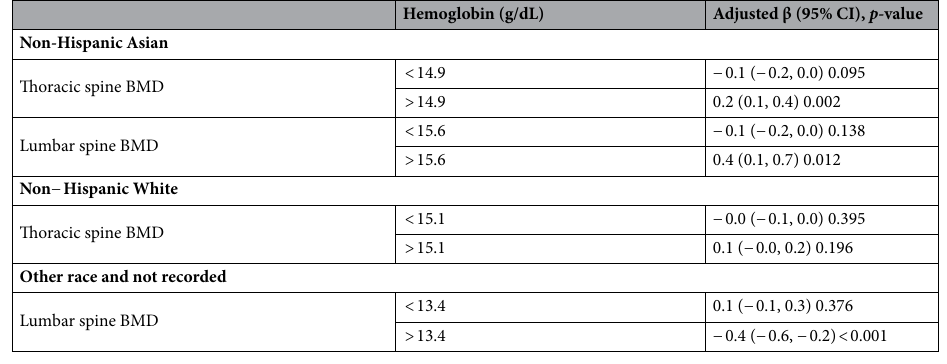
Table 5. Threshold effect analysis of HGB on Thoracic Spine BMD and Lumbar Spine BMD using two- piecewise linear regression. Age, sex, annual household income, education level, SBP, DBP, BMI, red blood cell count, albumin, ALP, ALT, blood urea nitrogen, total calcium, iron, CPK, creatinine, glucose, LDH, phosphorus, total bilirubin, total protein, uric acid, albumin creatinine ratio, blood cadmium, blood lead, phosphorus, potassium, triglyceride, LDL-C, HDL-C, total cholesterol, alcohol status, smoking status and diabetes were